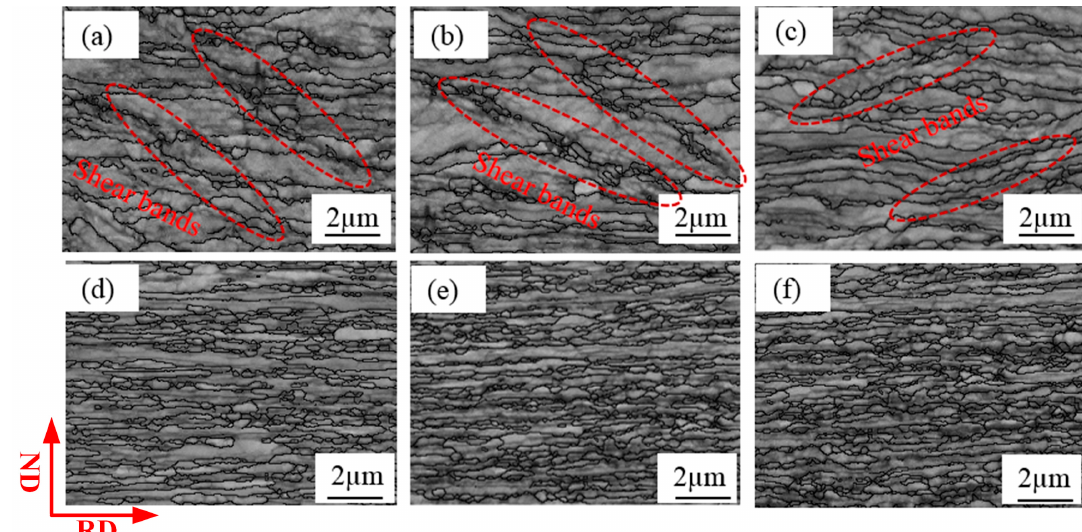
Figure 8. Electron backscatter diffraction (EBSD) images for the rolling specimens with thicknesses of ( a ) 600 µm, ( b ) 400 µm, ( c ) 200 µm, ( d ) 80 µm ( e ) 40 µm, ( f ) 20 µm.